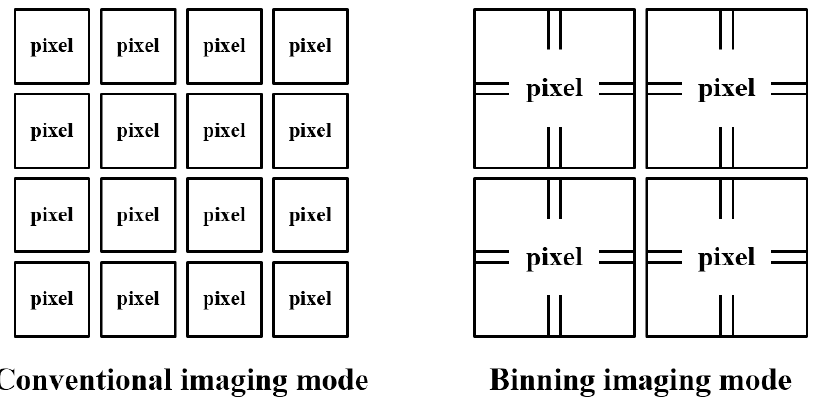
Figure 9. Conventional imaging and binning imaging schematic diagram.